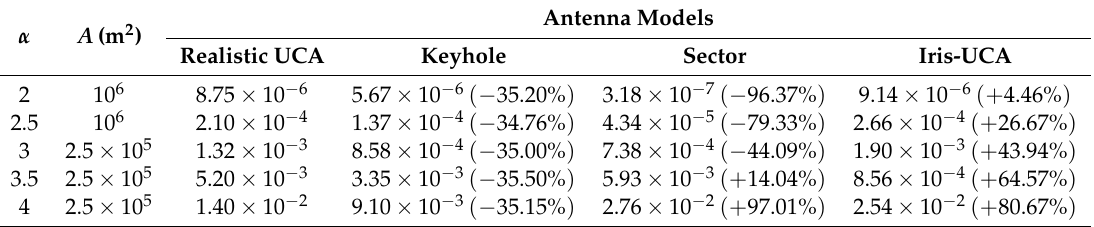
Table 5. Critical node density ρ c with UCA antenna, keyhole, sector and iris-UCA models when σ = 4. α A (m 2 )